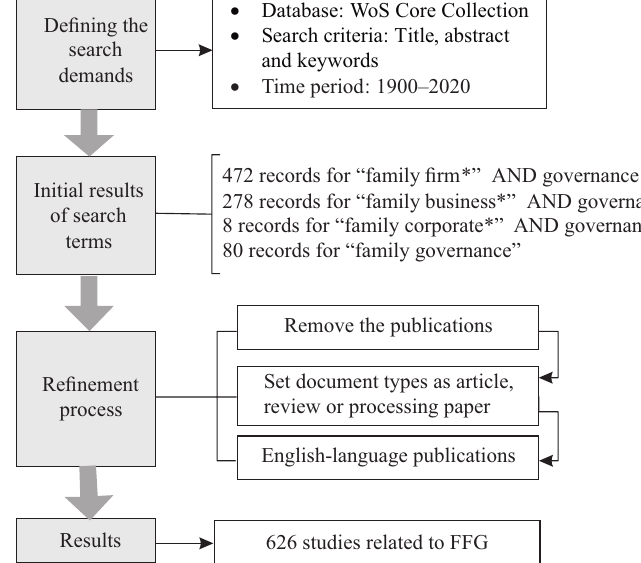
Figure 3. The data collection